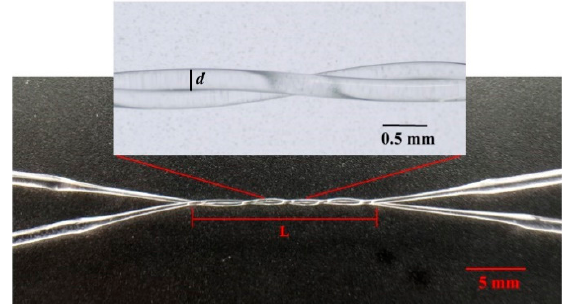
Figure 1. Photo of the twisted tapered plastic optical fibers (POFs), L is the twisted region length, and d is the tapered fiber